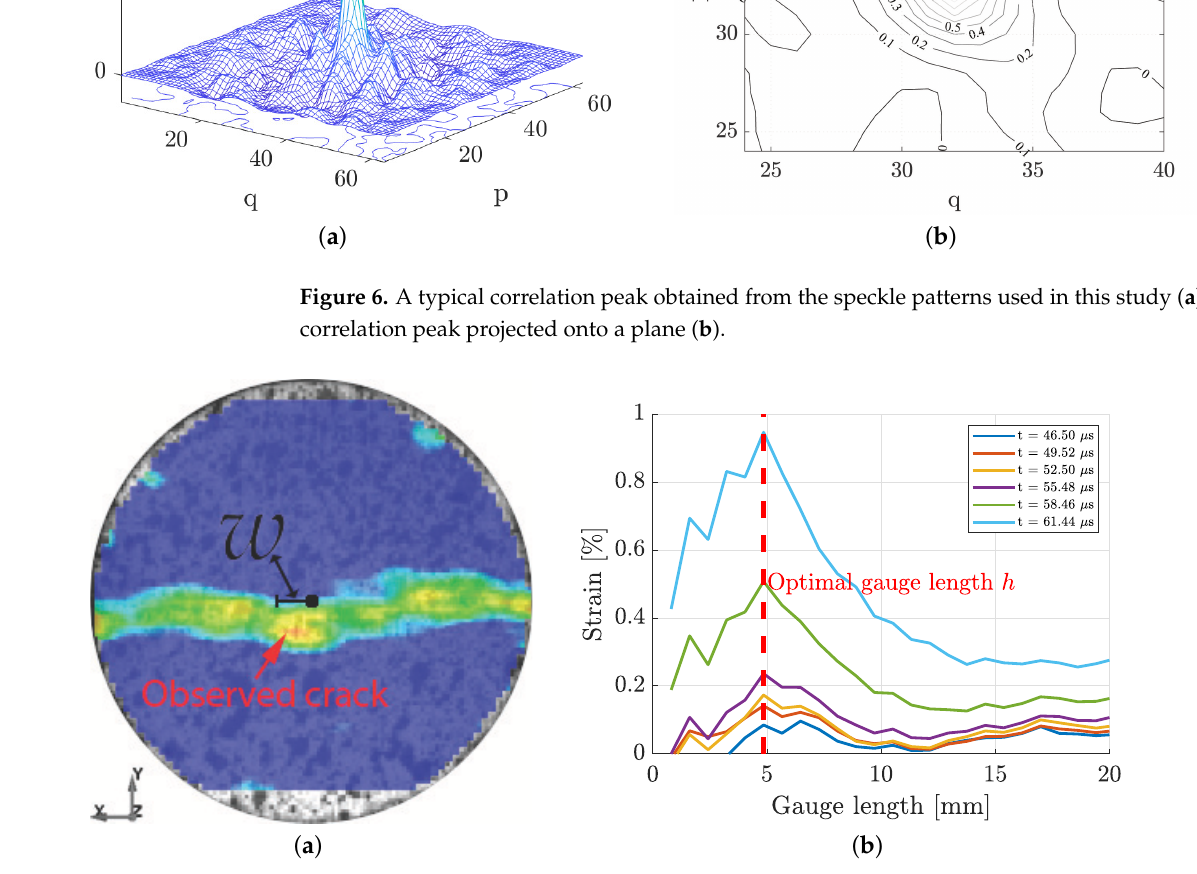
Figure 7. An example of the measurement of the horizontal distance from the centre to the point of observed crack initiation in the Brazilian disc test of granite ( a ) and an example of the effects of gauge length for measuring the indirect strain of granite ( b